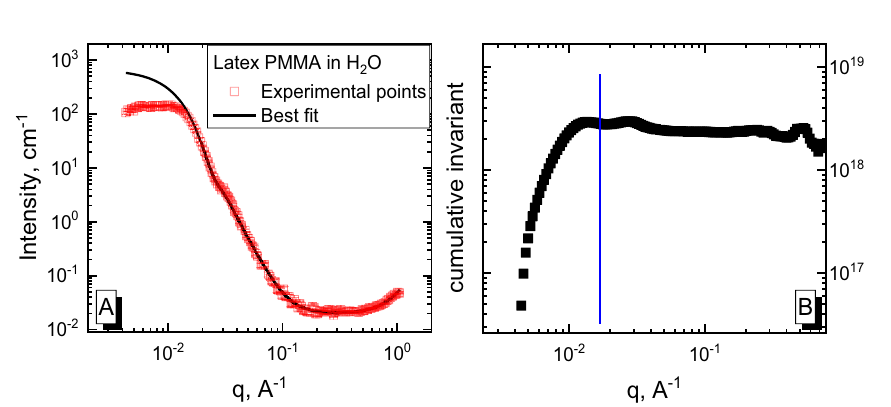
Figure 6. (A) Small-angle X-ray scattering curves of PMMA latex particles in water and its best fit; (B) appropriate cumulative invariant with the labeled q max value as a vertical blue